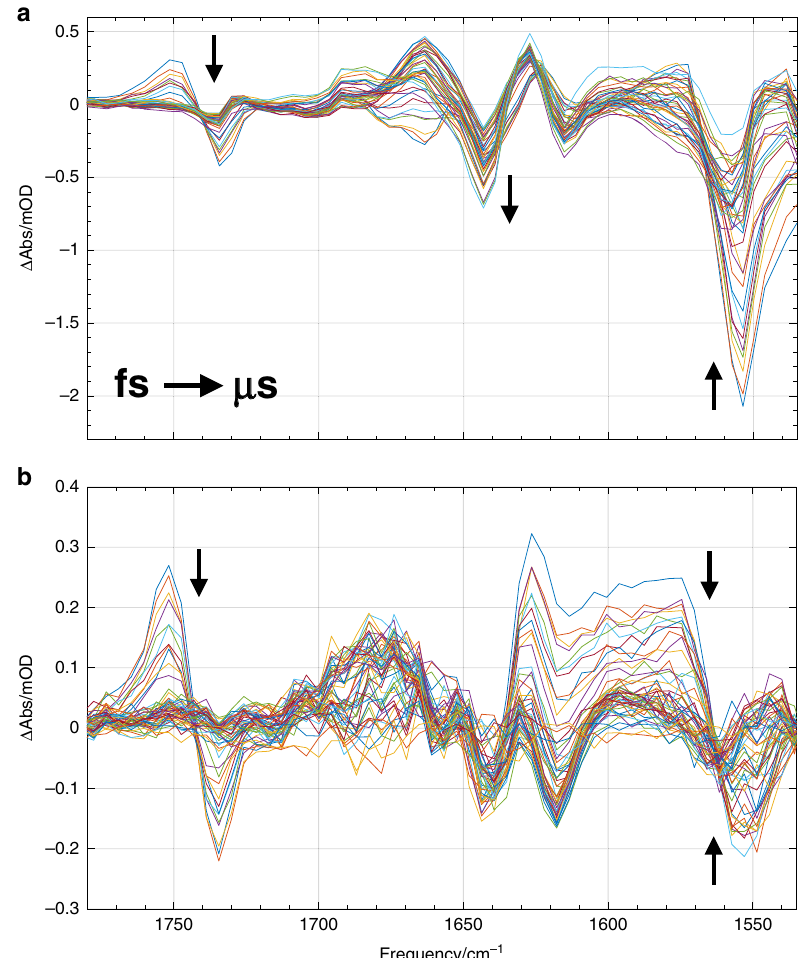
Fig. 2 Transient absorption difference spectra in the midinfrared. A selection of transient absorption difference spectra in the mid-IR spectral region following excitation with 475 nm light for a PYP S and b PYP C , from 100 fs to 100 ms. Full spectra were recorded for each laser pulse after dispersing the probe light on a 64 element Mercury Cadmium Telluride photodiode array, resulting in a ~4 cm − 1 sampling resolution. Approximate temporal evolution from femtoseconds to microseconds is denoted by the black